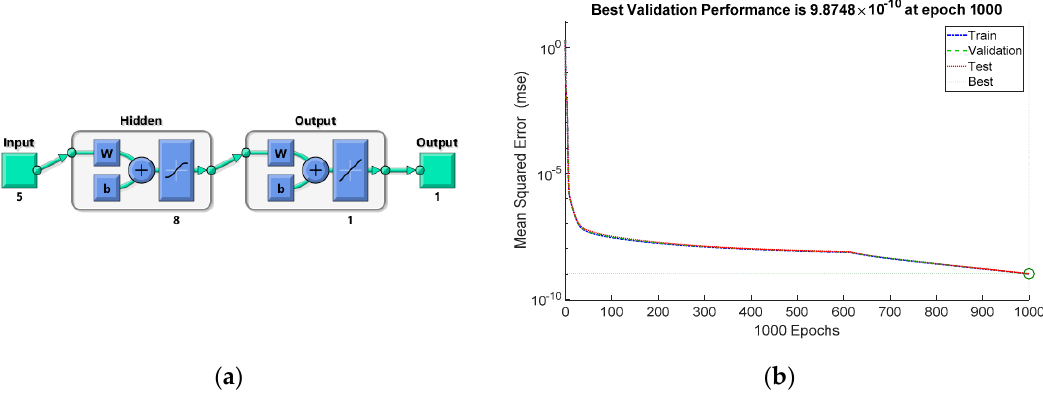
Figure 5. ANN obtained in example 1: ( a ) architecture, ( b ) performance of training.